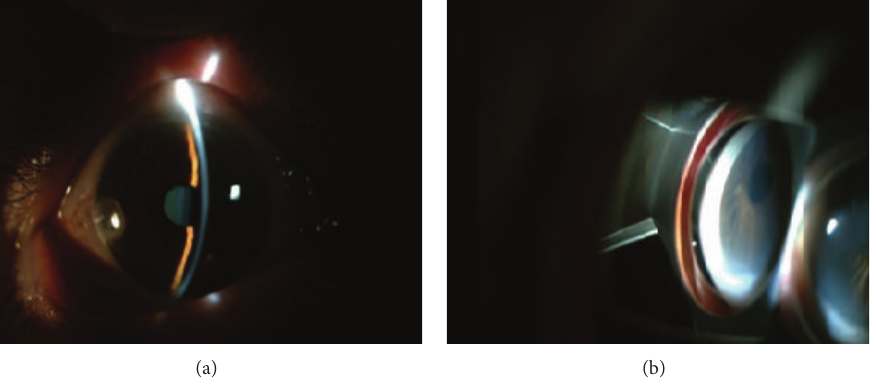
Figure 2: Ciliar injection in the conjunctiva (a), closure of iridocorneal angle (b), and narrow anterior chamber (a) in the left eye.